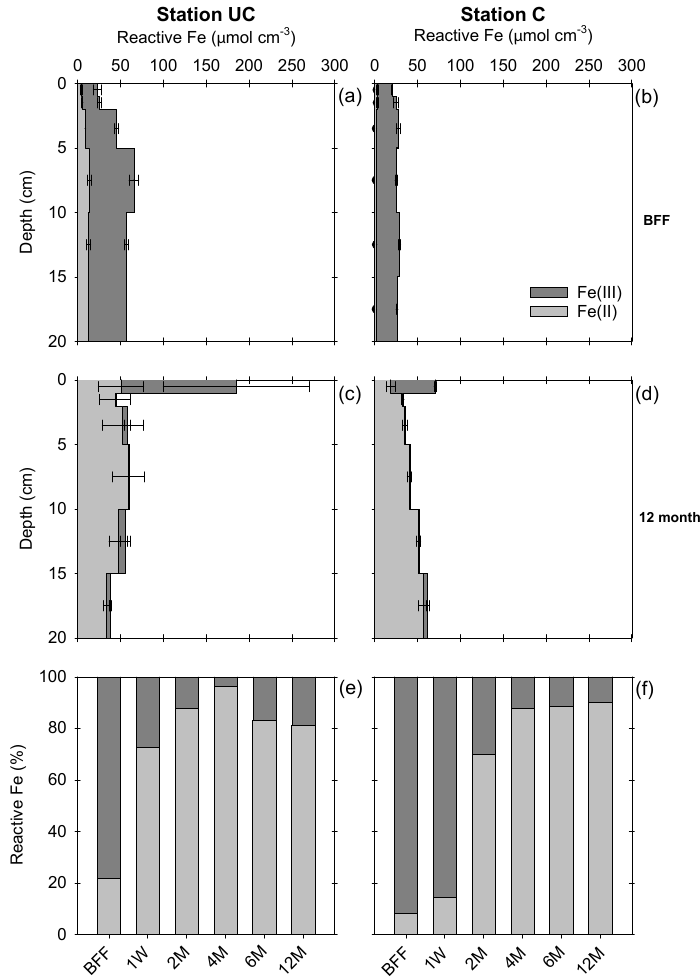
Figure 6. Upper panels (a, b) show concentration of reactive Fe(II) and Fe(III) in uncultivated (UC) and cultivated (C) soils before flooding (BFF) and 12 months after flooding. Lower panels (e, f) show the relative contributions of reactive Fe(II) and Fe(III) in the upper 20cm at various times after flooding at 1 week (1W) and 2, 4, 6 and 12 months (2M, 4M, 6M and 12M), respectively. Error bars indicate SEM ( n =